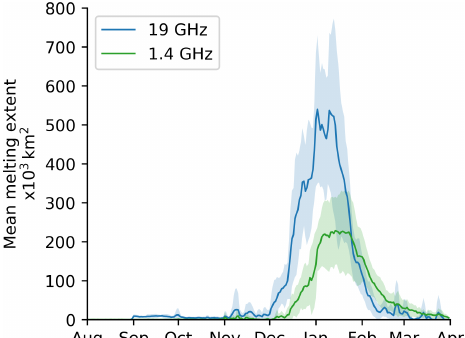
Figure 2. Daily mean melting extent from April 2010 to March 2018 detected with observations at 1.4GHz (green) and at 19GHz (blue). Standard deviation is in pale